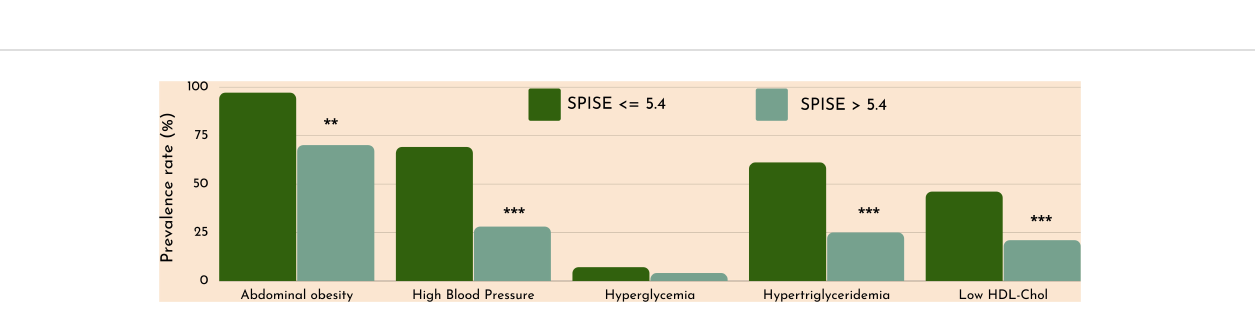
FIGURE 3 Cardiometabolic risk in obese adolescents according to optimal SPISE cutoffs for MetS and IR screening (SPISE ≤ 5.4). MetS components diagnosed with the Cook et al. phenotype. Pearson ’ s c 2 test: *Signi fi cance at a =0.05. ***Signi fi cance at a <0.0001.